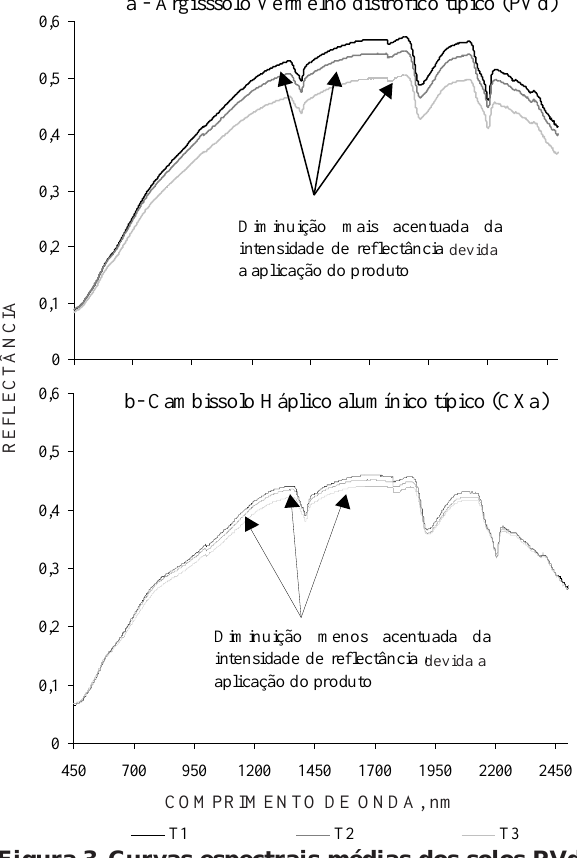
Figura 3. Curvas espectrais médias dos solos